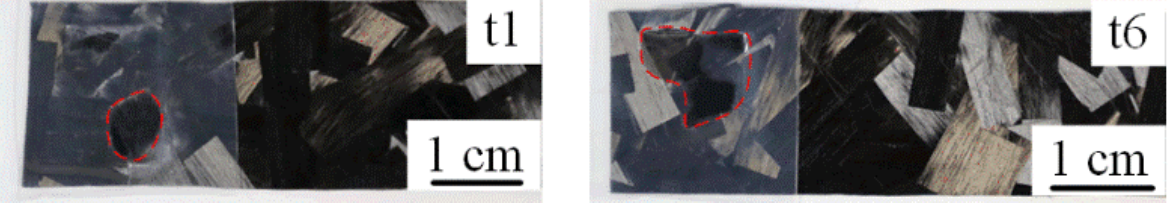
Figure 18. Representative fracture surface of category 1.